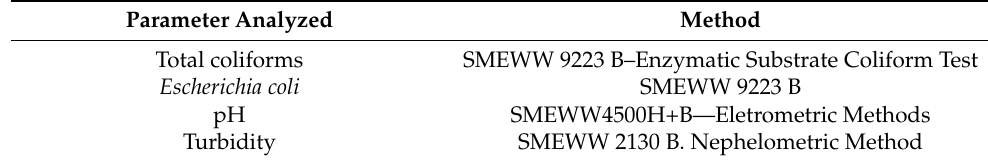
Table 1. Methods used for analysis of the parameters evaluated in the present